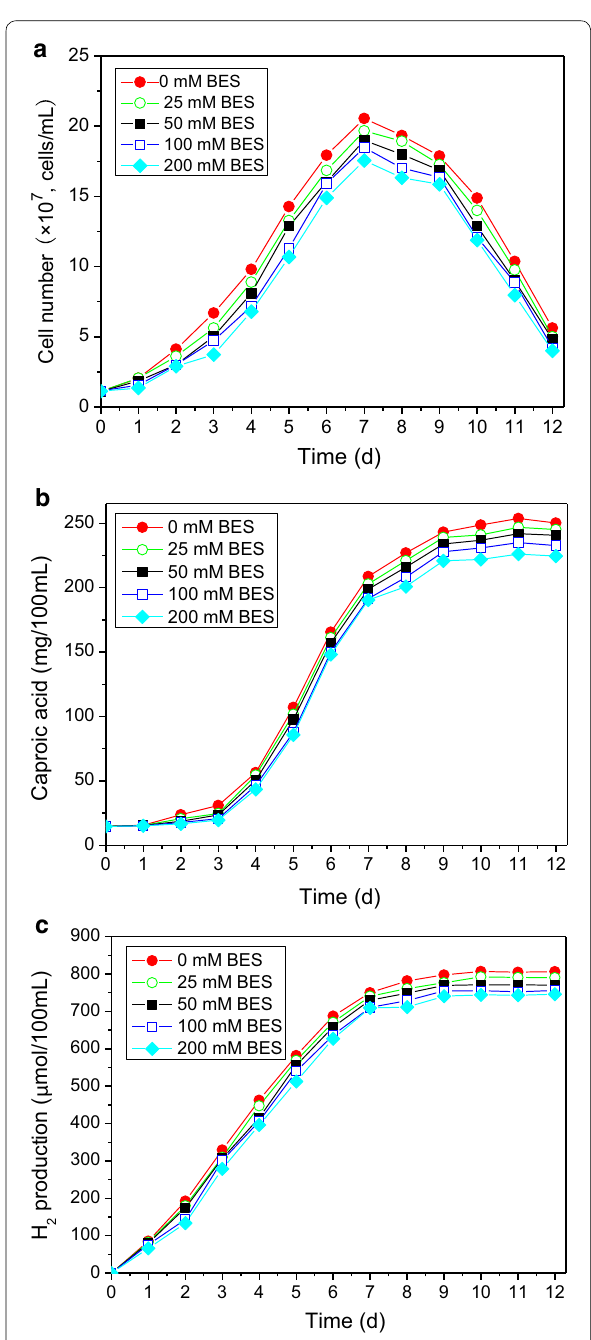
Fig. 4 Accumulation of cell number ( a ), caproic acid ( b ) and H 2 ( c ) in the single culture fermentation of C. kluyveri H588 under different